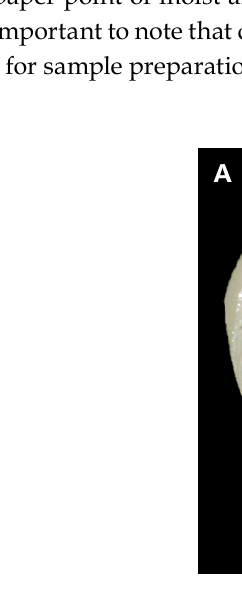
Figure 1. (A) Moist dentin, (B) Dry dentin.